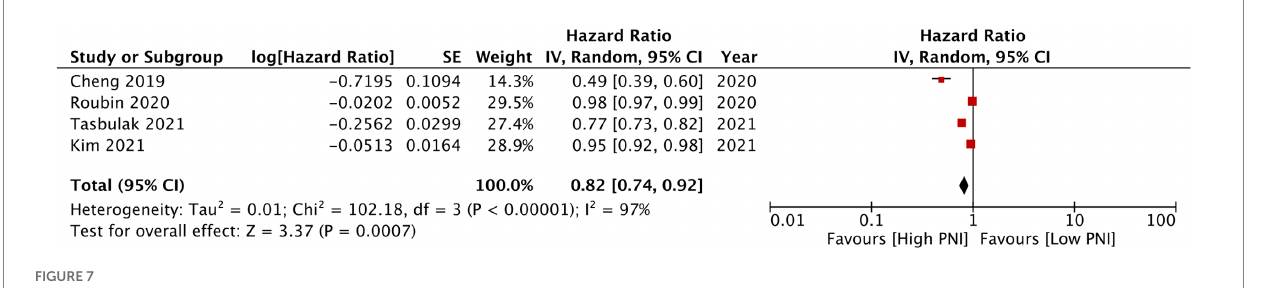
FIGURE 7 Meta-analysis of MACE with PNI as a continuous